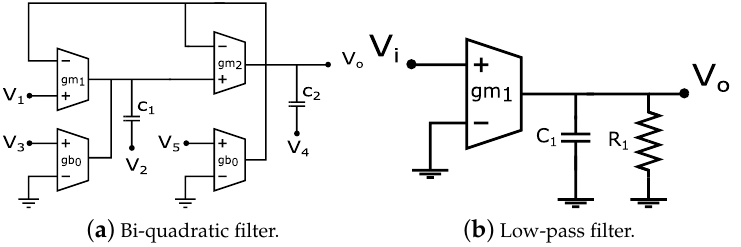
Figure 6. OTA-based active